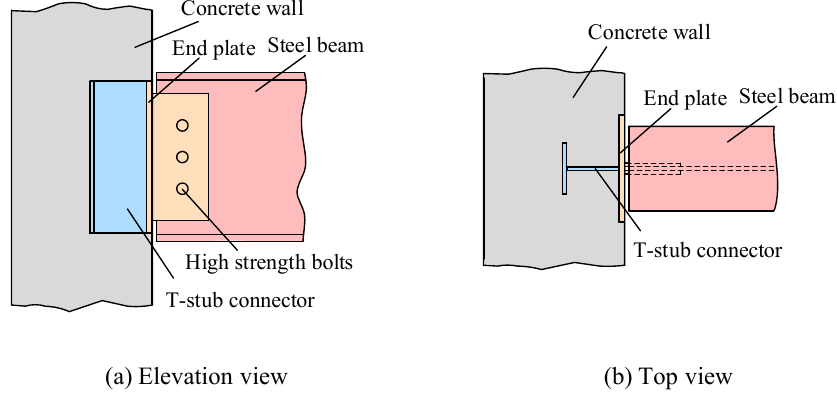
Figure 2. The SBCW joint with a T ‐ stub steel connector.